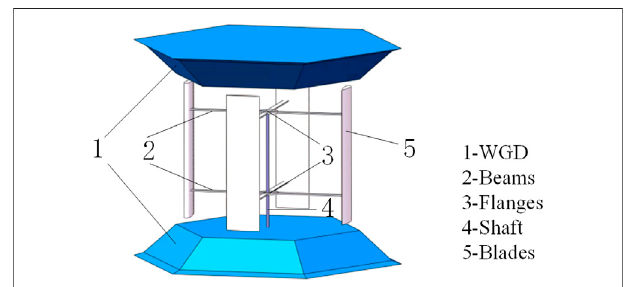
FIGURE 1 | Concept of the polyline hexagonal pyramid-shaped